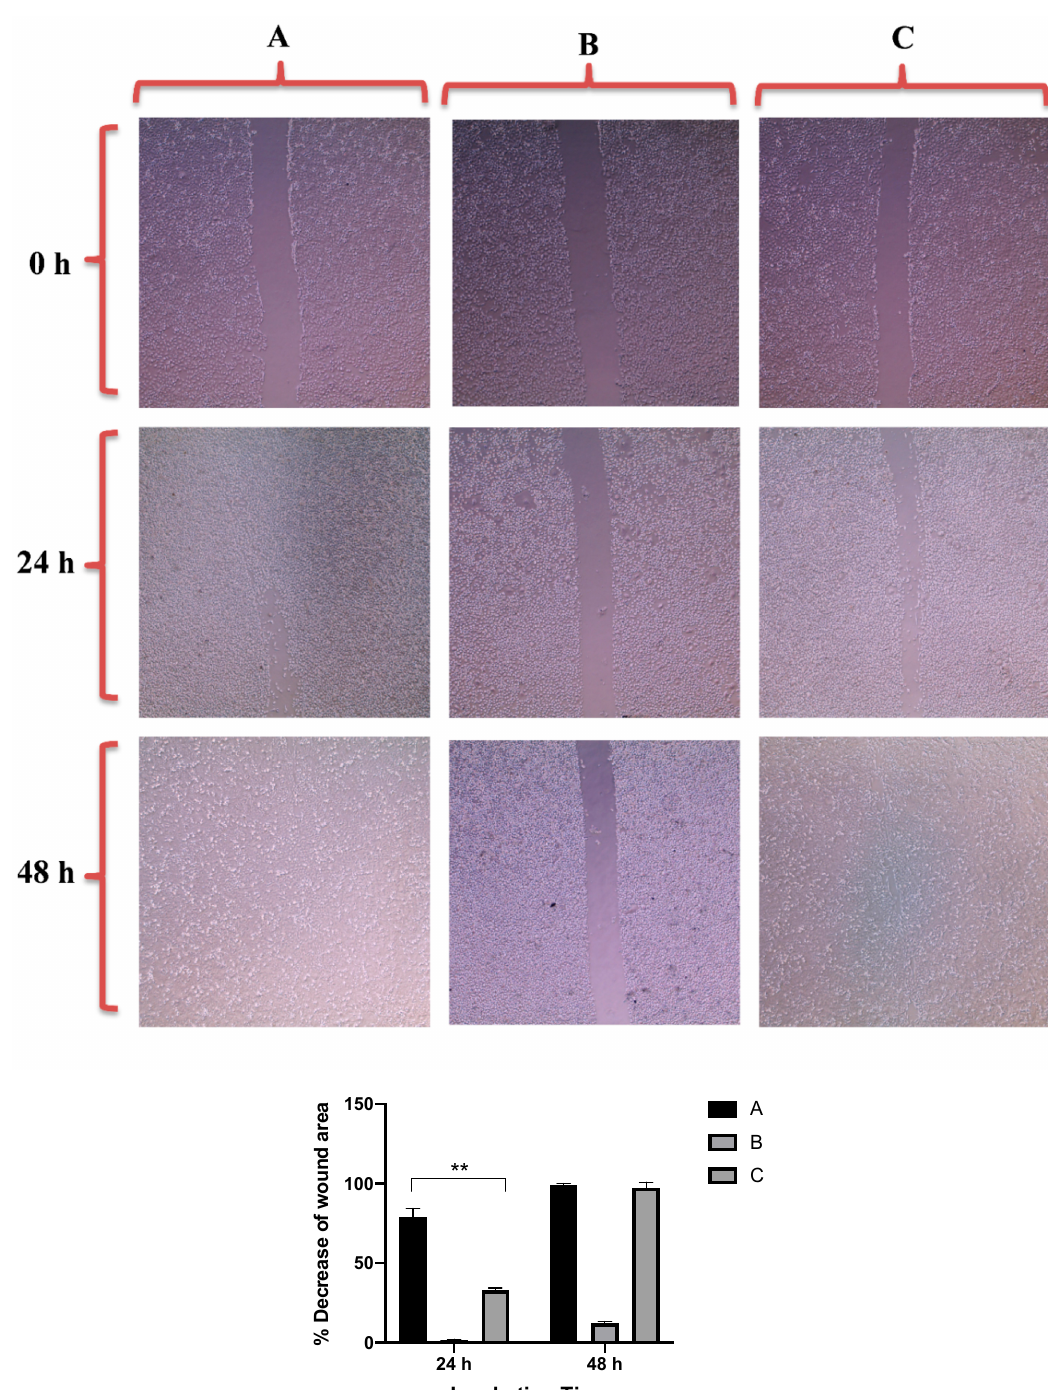
Figure 9. Up: In vitro cell migration of PC3 cell line (control untreated cells) ( A ), upon treatment with positive control (quercetin) ( B ), and upon treatment with GNRs-PEG-PDA ( C ). Magnification power: 10×. Down: The percentage decrease in wound area was estimated using ImageJ. Data are represented as mean ± standard deviation (SD), n = 3. t -test was employed for the difference assessment; ** p < 0.01.